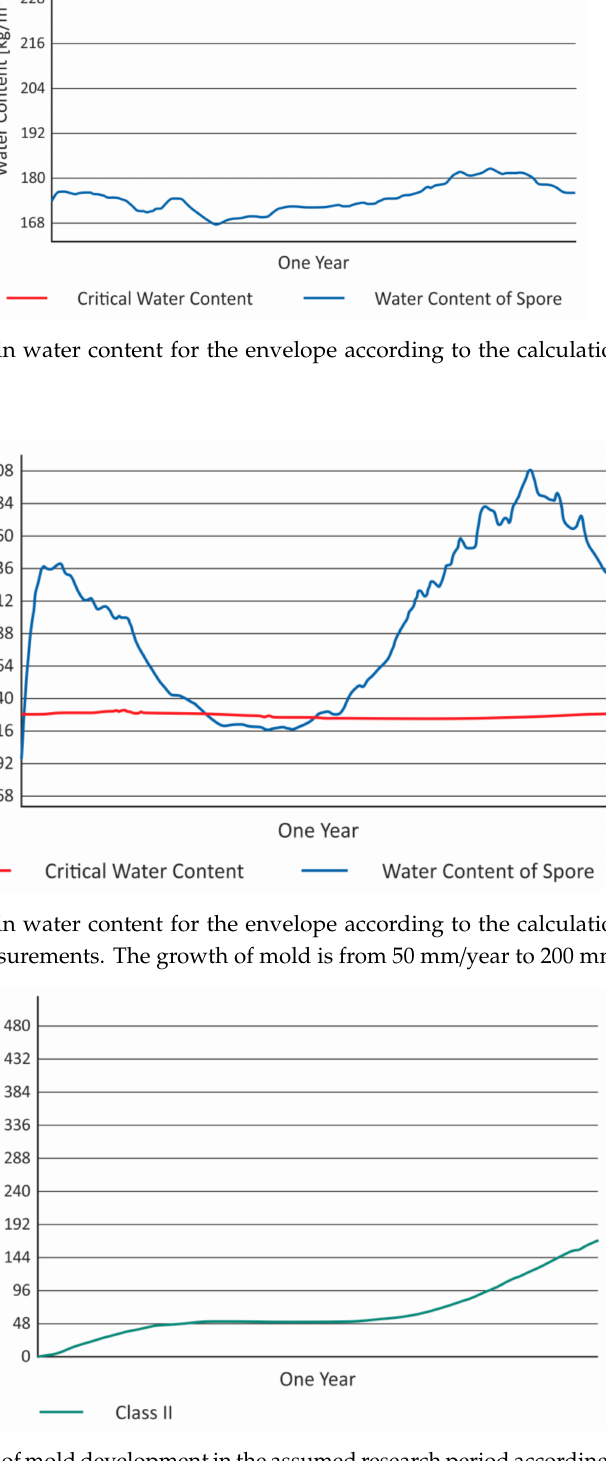
Figure 20. The course of mold development in the assumed research period according to the calculations for the indoor climate from the